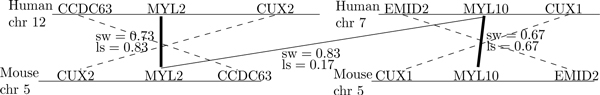
Incorrect pairing due to similar sequence similarity corrected by BBH-LS. BBH erroneously paired MYL2 (human) to MYL10 (mouse) because of high Smith-Waterman score, this was corrected by BBH-LS with the help of local synteny score. Bold edges are the pairing from BBH-LS, thin edges are the pairing from BBH, sw = normalized Smith-Waterman score, lc = normalized local synteny score.